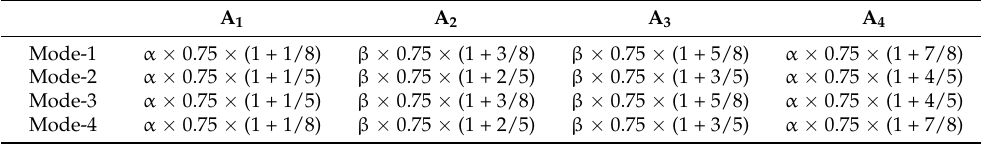
Table 6. Four modes of 4-level